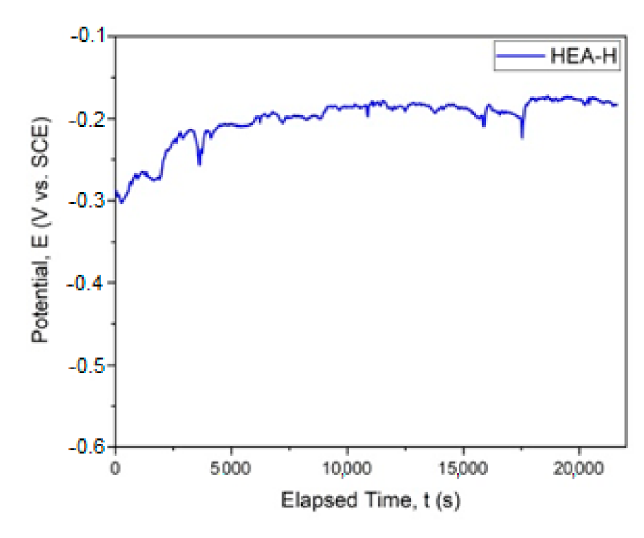
Figure 4. Corrosion potential for HfNbTaTiZr HEA. (HEA-H).